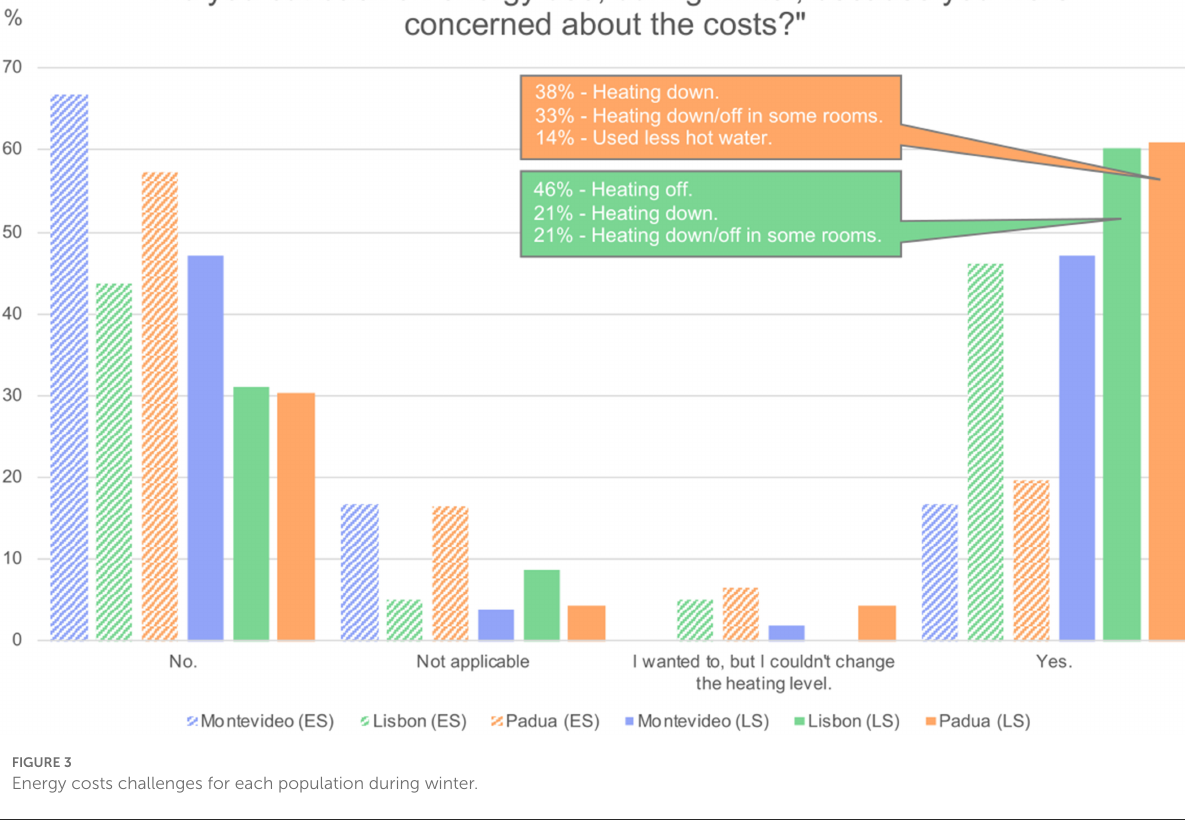
FIGURE3 Energy costs challenges for each population during winter.